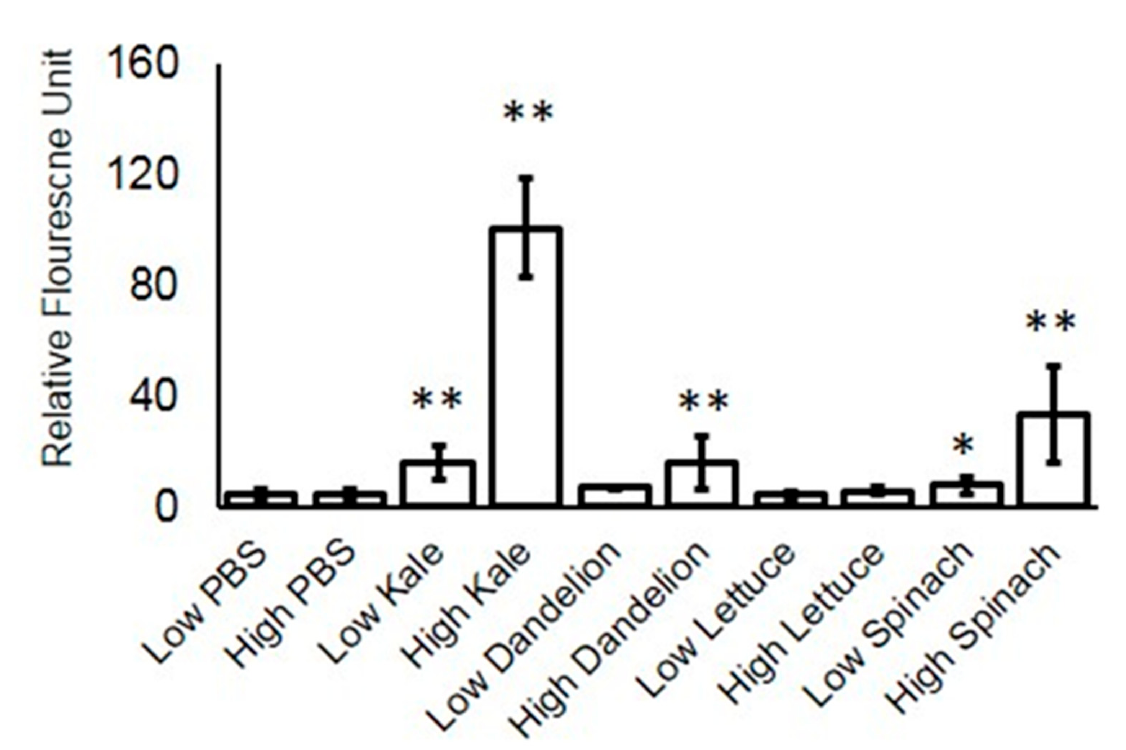
Figure 6. Measurement of reactive oxygen species (ROS) in SH-SY5Y cells after treating with kale, dandelion, spinach, and lettuce juices. Cells were seeded in 96-well plates and treated with the various dilutions of vegetable juices for 24 h. After treatment, the cells were washed with PBS and stained with 10 µ M dichloro-dihydro-fluorescein diacetate (DCF-DA) diluted in PBS and incubated at 37 ◦ C for 30 min in the dark. After incubation, the cells were washed, and cellular ROS production was measured by the amount of fluorescence ( λ ex / λ em = 485/535 nm) detected on a fluorescent plate reader. Data expressed as relative florescence unit (RFU). Data represents mean values of n = 8 ± SD. Statistical significance was determined by student’s t-test (* p ≤ 0.05, ** p ≤